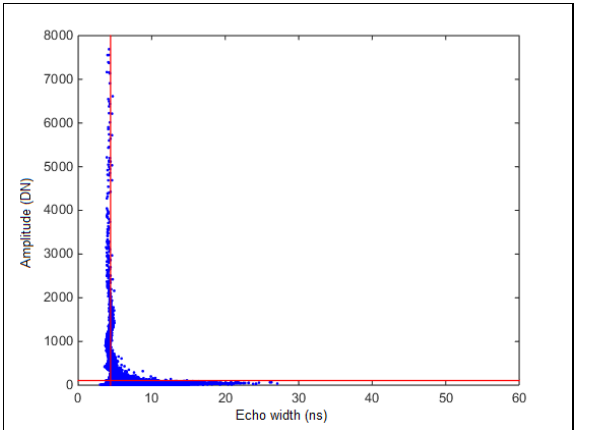
Figure 9. Vienna dataset: Scatterplot of Echo Width versus Amplitude for single echoes. Echoes with more than 1% of the highest Amplitude are placed above the red horizontal line. The vertical line shows the minimum echo width EW min which is 5% quantile of the single echoes above the Amplitude threshold.